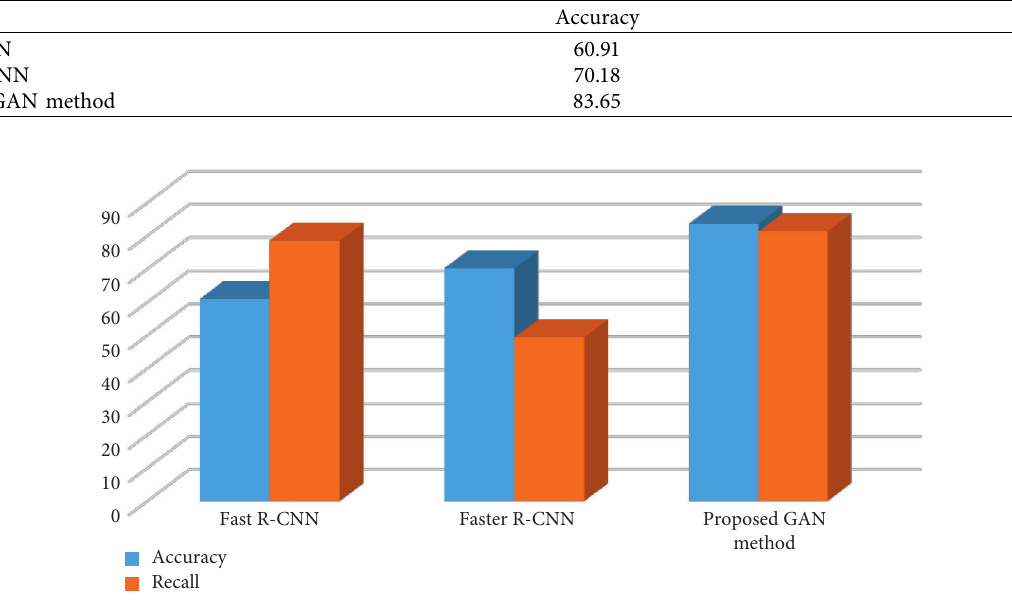
Figure 6: Accuracy and recall comparison across methods.